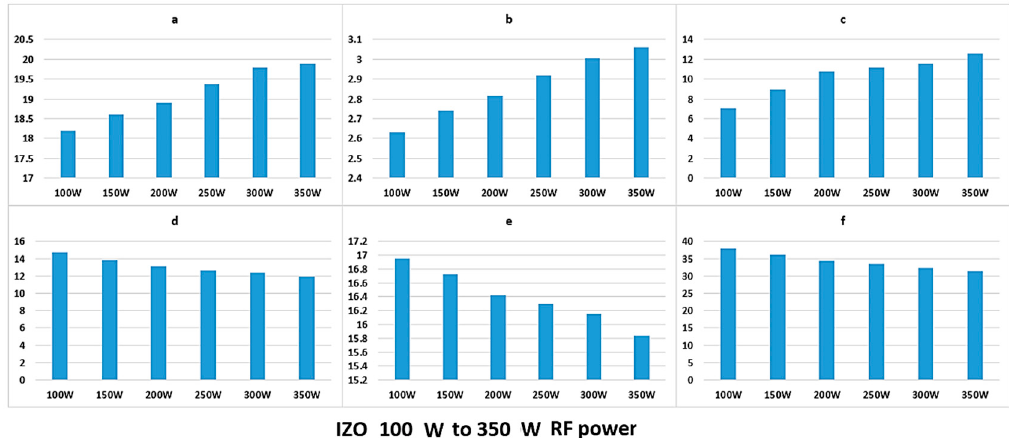
Figure 15. These data demonstrate the ratio (to the total spectral cover from 300 to 800 nm) of the area under the peak in each of the segments in response to the RF plasma power applied for maintaining the plasma. The peak area associated with segment ( a – c ) tend to be increasing with increasing the applied power, while emissions associated with sections ( d – f ) are reducing.